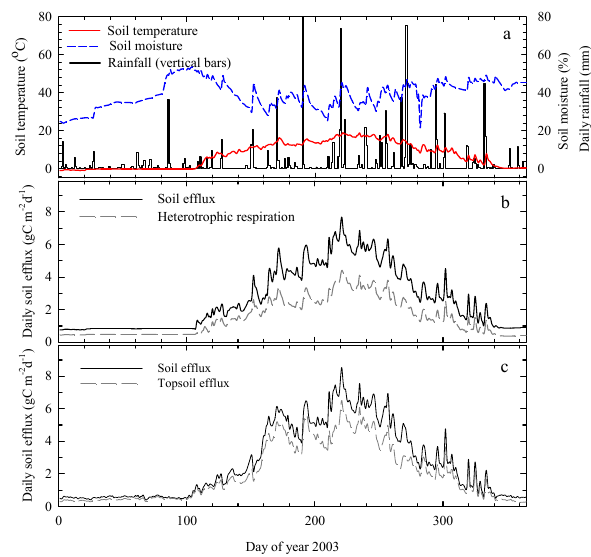
Fig. 3. Fig. 3. Seasonal variations in daily means or sums of (a) soil tem- perature at a depth of 0.05m (solid line), precipitation (bars) and volumetric soil moisture at a depth of 0.1m (dashed line), (b) to- tal soil respiration (solid line) and heterotrophic respiration (gray dashed line) measured with the automated chamber system, (c) and total soil respiration (solid line) and topsoil (O a and A horizons) ef- flux (gray dashed line) measured with the gradient system. For the chamber method, measurements were conducted between DOY 108 and 345. Other values were estimated by using the Q 10 function of Eq.